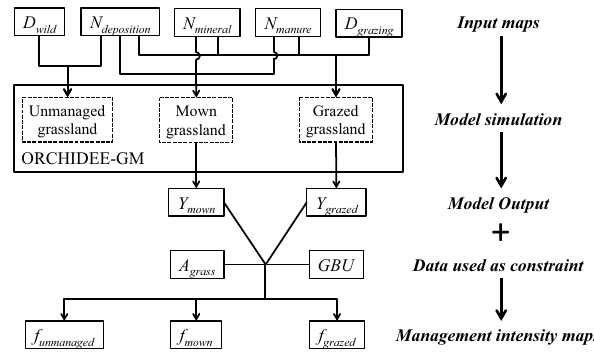
Figure 1. Illustration of the procedures for reconstructing manage- ment intensity maps. Italic texts indicate the major steps of the reconstruction. The meanings, units, related equations, and data sources of the variables (i.e. gridded maps) are shown in Table 1.